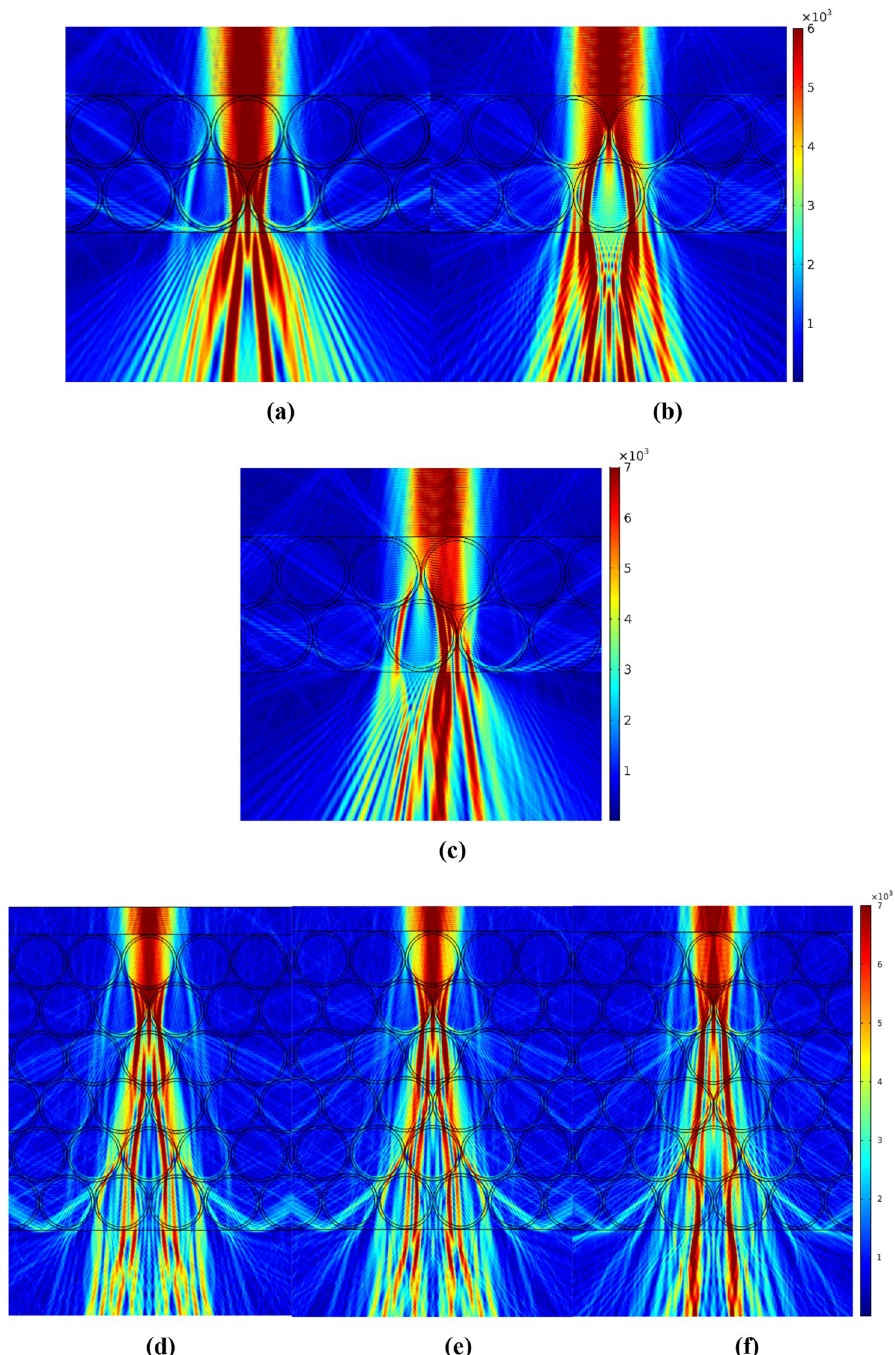
Figure 3. Simulations of Gaussian light beam propagation (waist of the beam is of 10 μm) through 2D fat tissue model (3-layer cell model at immersion in ISF with n = 1.36): two cell layer tissue model ( a )-( c ) and six-cell layer tissue model ( d ); symmetric [( a ), ( b ) and ( d )], and nonsymmetric light beam incidence (c); incidence to cell center in the upper layer ( a ) and ( d ); incidence between two adjusted cells ( b ); six-cell layer tissue model ( e ) and ( f ) with the incidence to cell center in the upper layer at immersion in ISF with n = 1.38 and 1.40,